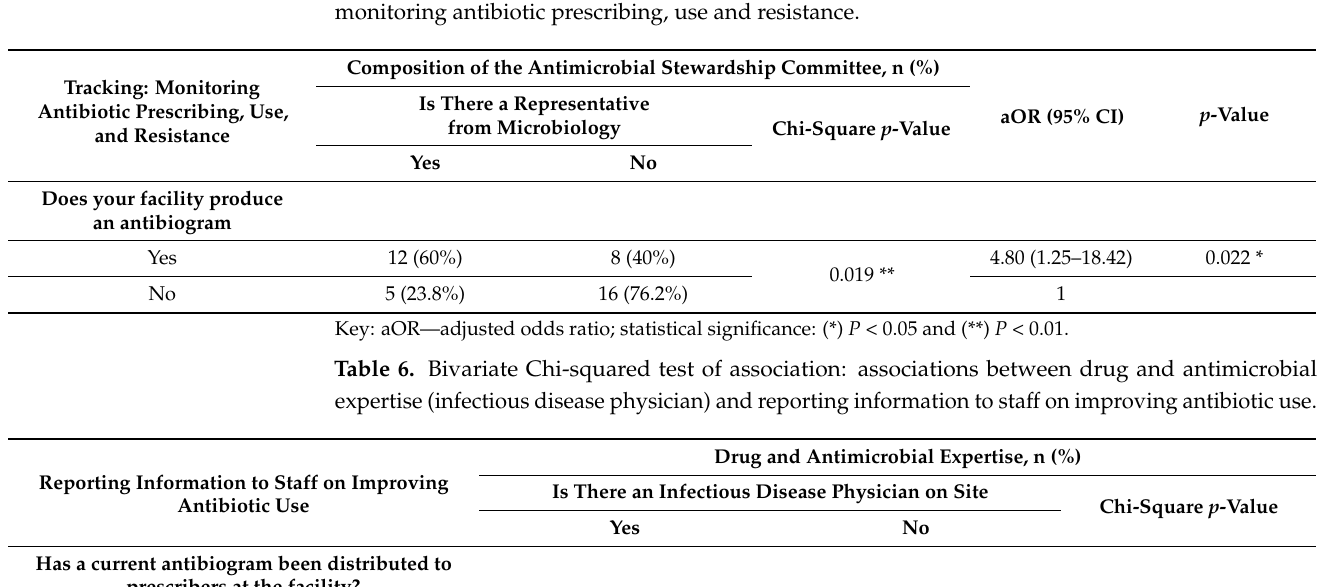
Table 5. Bivariate Chi-squared test of association and univariate logistic regression: associations be- tween composition of the antimicrobial stewardship committee (clinical microbiologist) and tracking: monitoring antibiotic prescribing, use and resistance.